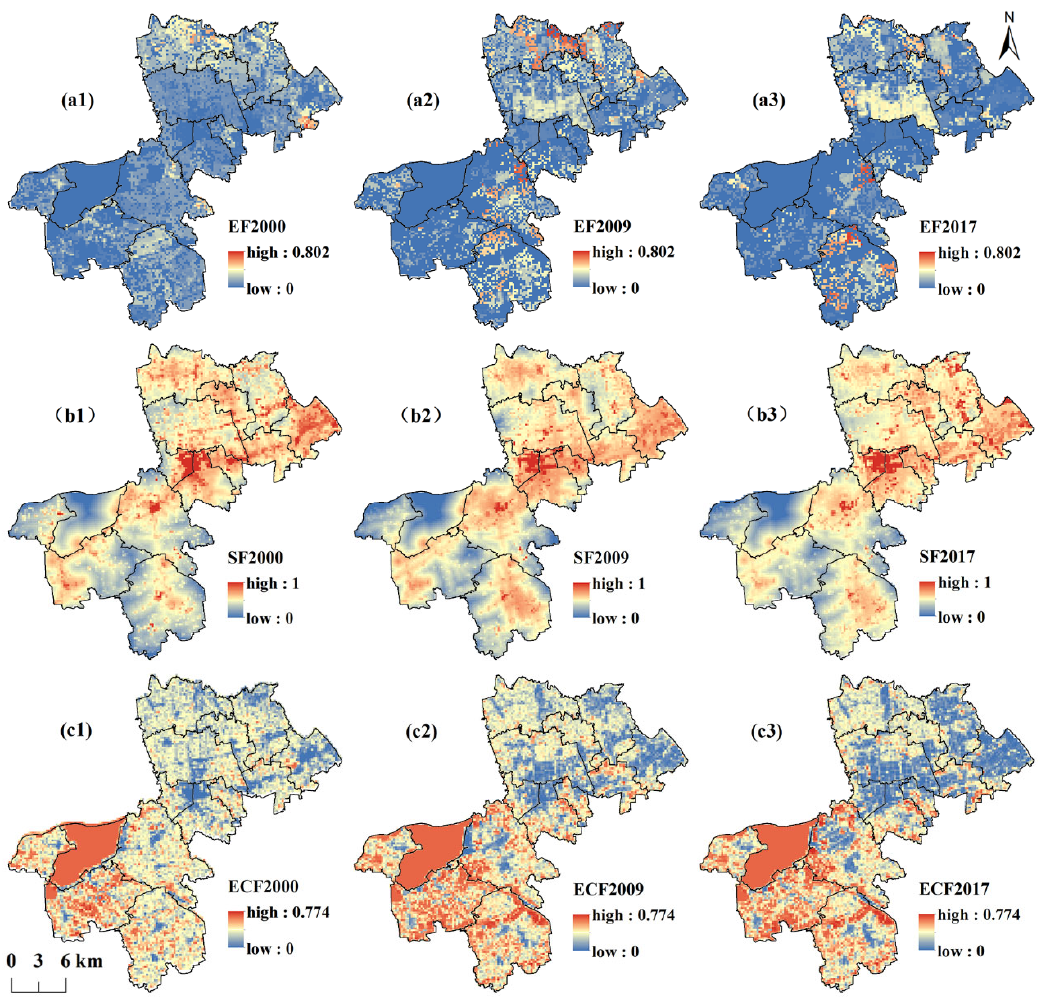
Figure 4. Spatial distribution of land use primary functions in Qingpu District from 2000 to 2017. The land use primary functions include three functions: economic function (EF) in 2000 ( a1 ), 2009 ( a2 ) and 2017 ( a3 ); social function (SF) in 2000 ( b1 ), 2009 ( b2 ) and 2017 ( b3 ); ecological function (ECF) in 2000 ( c1 ), 2009 ( c2 ) and 2017 ( c3